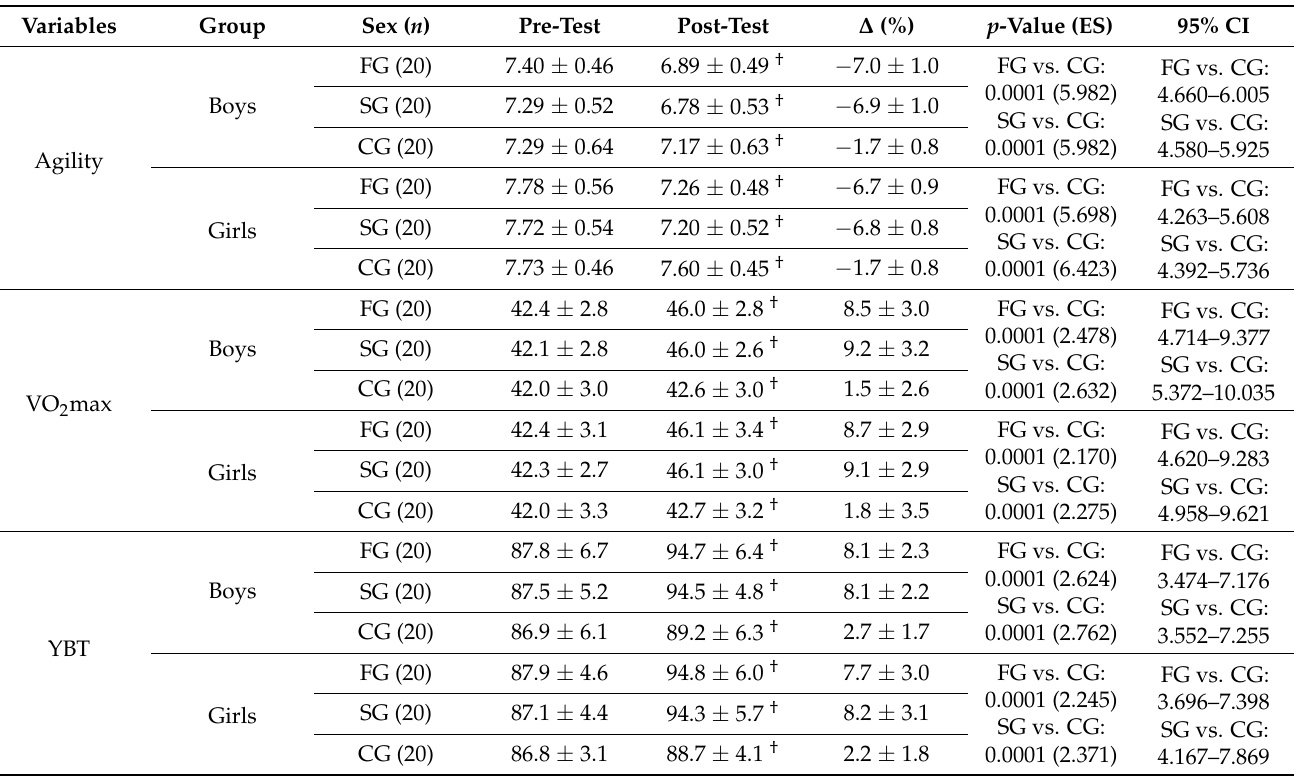
Table 4. Agility (s) and maximal oxygen consumption (mL · kg − 1 · min − 1 ) performances, along with the composite score for the Y-balance test (%) at baseline and after the intervention period for all groups ( n =